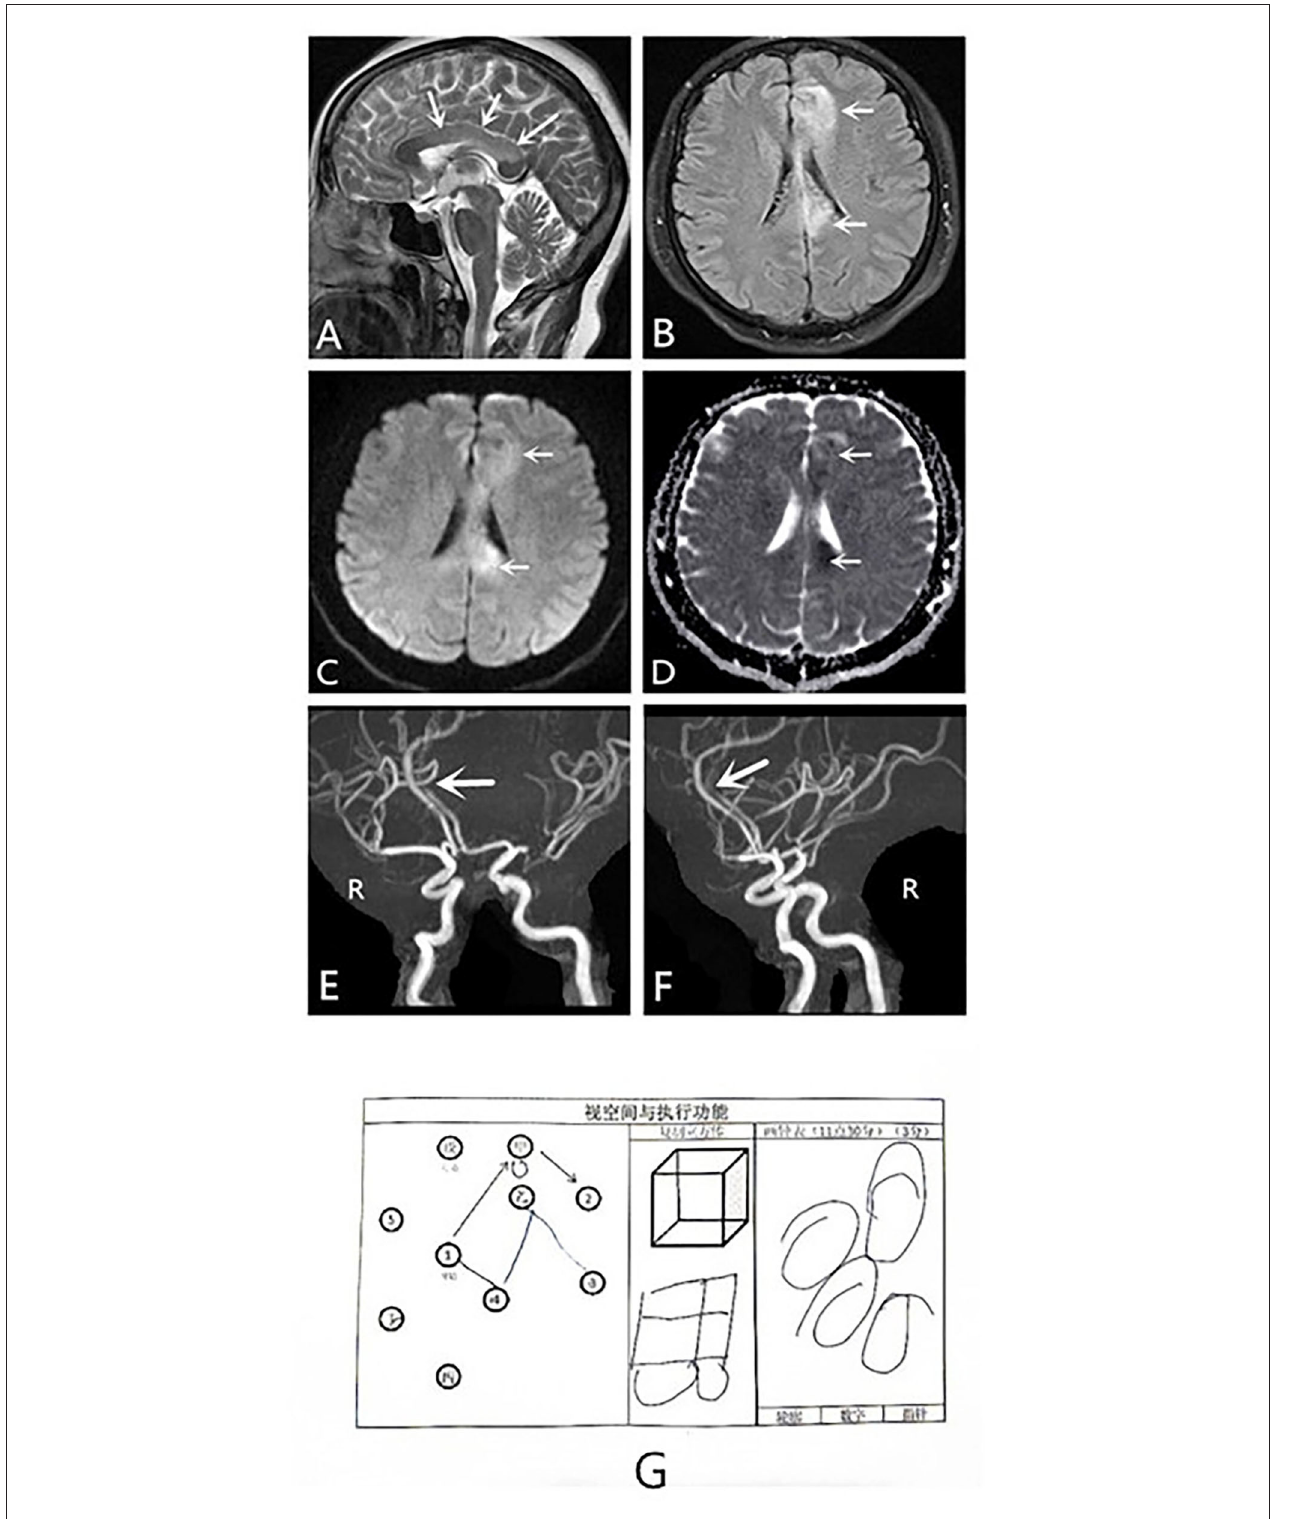
FIGURE 1 | MRI, MRA and visuospatial and executing skills of the dominant hand results of a patient with alien hand syndrome. MRI: (A–D) Sagittal T2WI scan, axial T2 FLAIR, DWI, and ADC scans show cytotoxic edema in the left frontal lobe and the body of the corpus callosum. ( E,F ) MRA shows poor visualization of the pericallosal artery and stenosis of the left middle cerebral artery. The patient failed to recognize spatial structure, known as constructional apraxia (G) . ADC, apparent diffusion coefficient; DWI, diffusion-weighted imaging; FLAIR, fluid-attenuated inversion recovery; MRA, magnetic resonance angiogram; MRI, magnetic resonance imaging; T2WI, T2-weighted